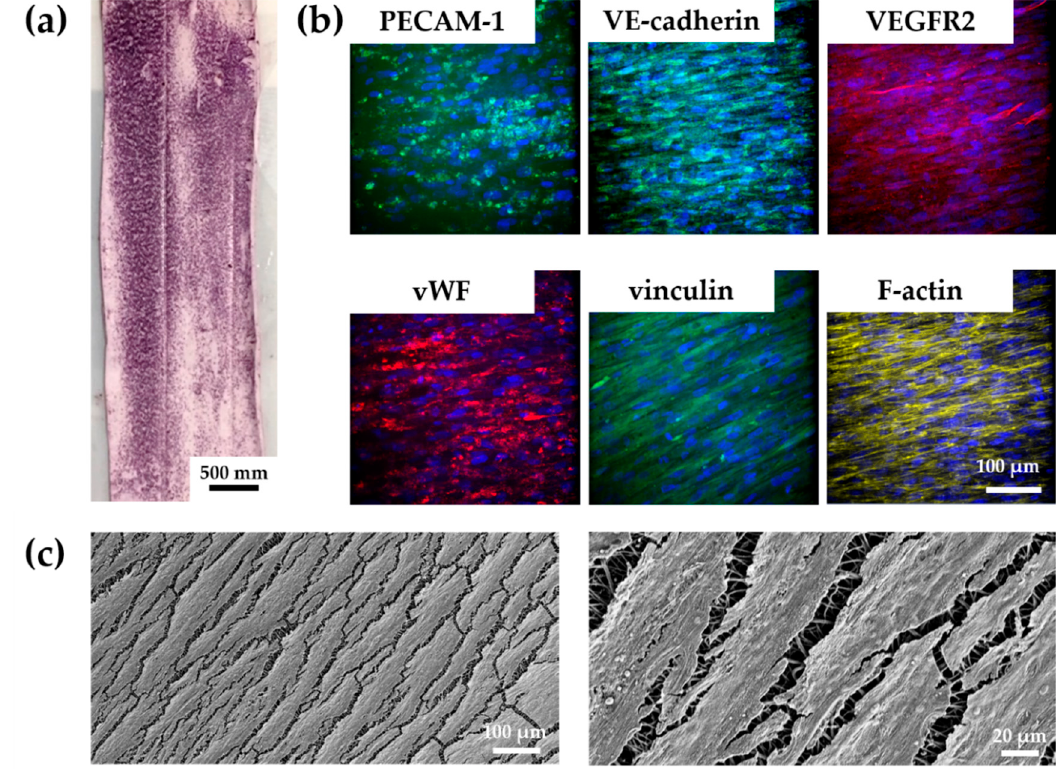
Figure 8. Tissue-engineering approach with vascular endothelial cells cultured for 7 days on FN-biofunctionalized electrospun tubular TPCU scaffolds under dynamic conditions: ( a ) Inner wall of the tubular construct shows living vECs indicated by the purple formazan stain. ( b ) PECAM-1, vWF, VE-cadherin, vinculin, VEGFR2, and F-actin expression were detected. vECs show an aligned morphology. ( c ) SEM confirms vECs that had aligned with the flow to which they were exposed to during the dynamic culture in the